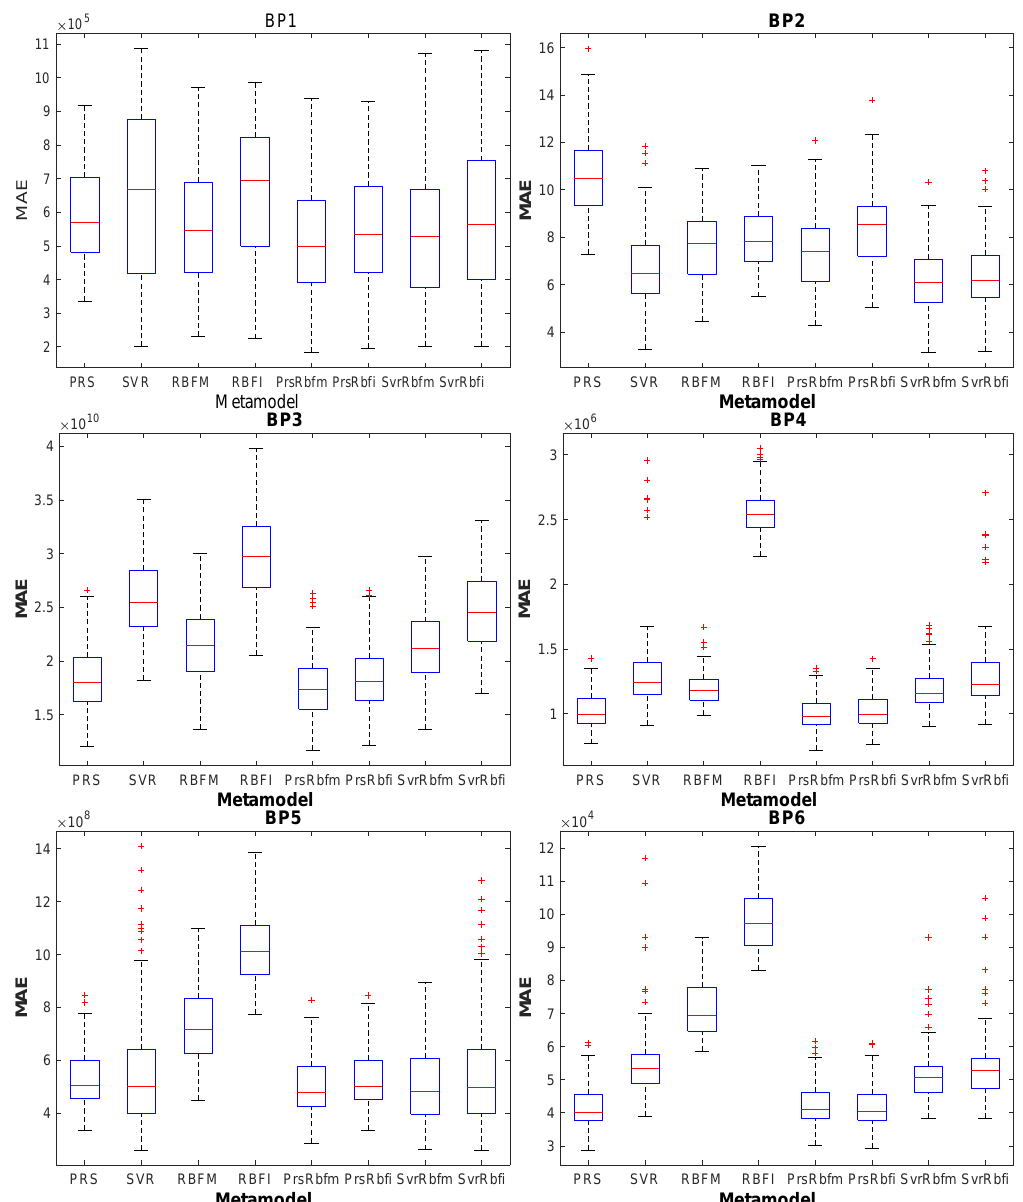
Figure 5. Boxplots of MAE of the metamodels over 100 test sets for each benchmark problem with 3 ( k + 1 )( k + 2 ) training 2